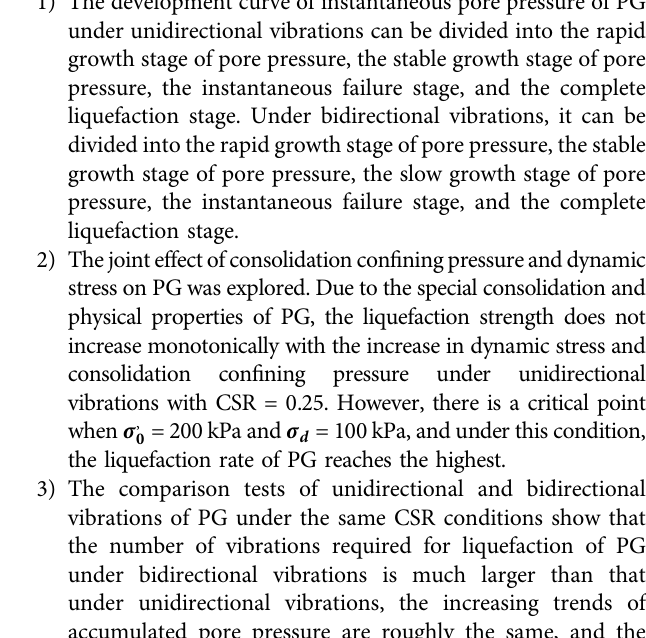
Frontiers in Earth Science |